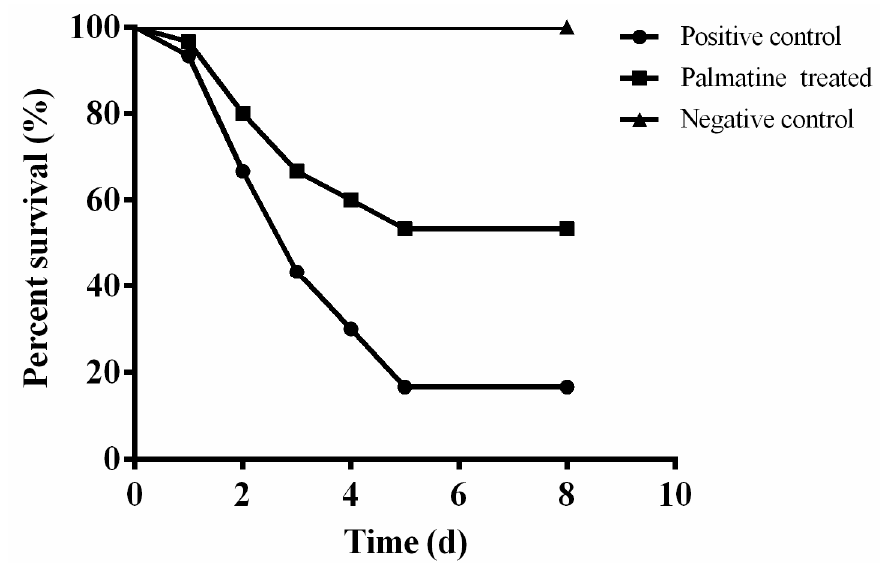
Figure 5. Palmatine treatment increased the survival rate of channel catfish challenged with A. hydrophila . Fish were administered with 50 mg/kg palmatine or sterile PBS at 12 h intervals for 3 days post-infection. Deaths were monitored for 8 days. The survival rate of the palmatine-treated group was significantly increased compared with infected fish without any treatment when analyzed by log rank test ( p < 0.0001).